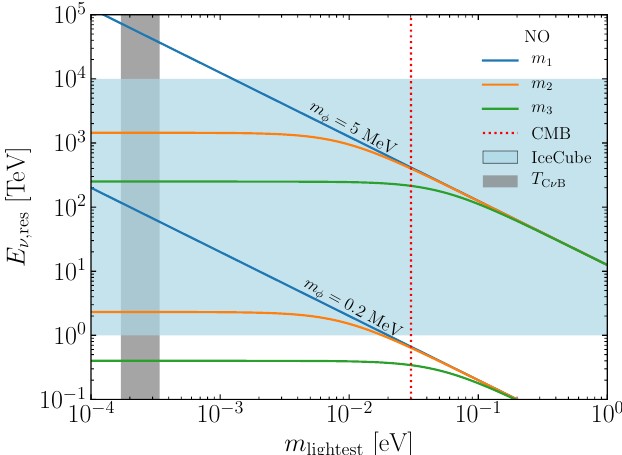
Figure 24.2: The resonant energy of each of the three C ν B mass eigenstates as a function of the lightest neutrino mass in the normal mass ordering. The blue band is the broadest range of energies that IceCube could possibly measure the astrophysical neutrino flux. The red dashed line indicates the limit from cosmology [ 267 ]